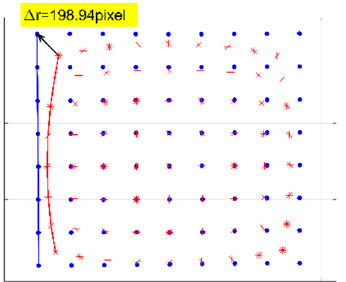
Figure 15. Corners image with the red asterisks representing the corners of the distorted checkerboard image and the blue points representing the corners of the corrected checkerboard image corresponding to those shown in Figure 14a,b. The curvature radius of the red line is 3.2457 × 10 3 pixels, and that of the blue line is 6.8656 × 10 4